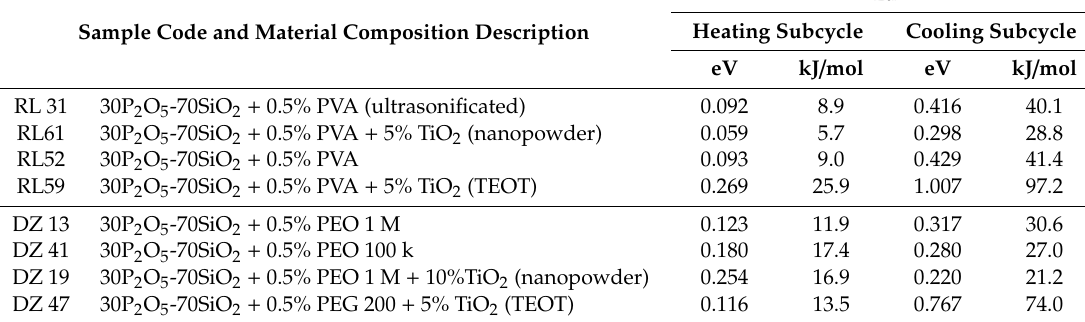
Table 1. Activation energies of Arrhenius-type conductivity dependencies for heating and cooling sub-cycles for all compositions of the studied